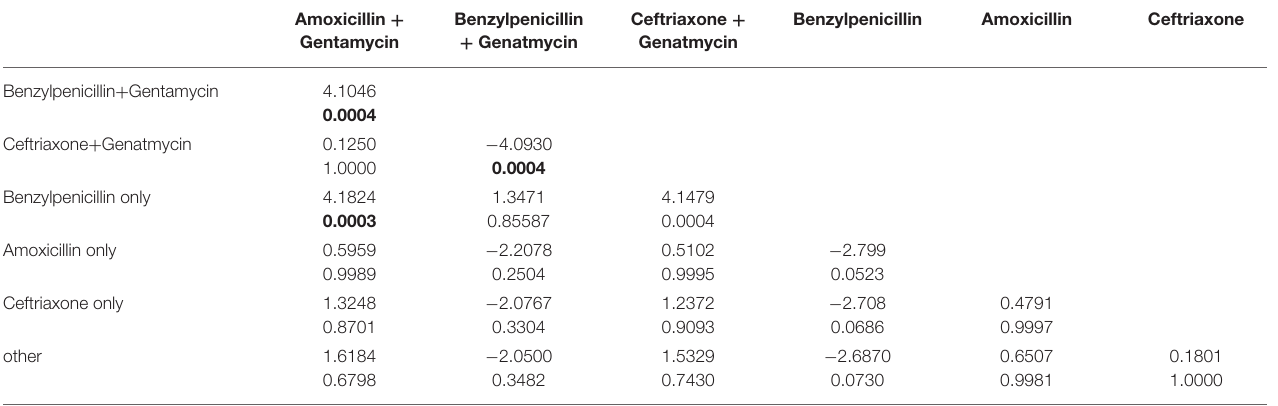
TABLE 4 | Dunn’s Pair-wise Comparison of cost of medicine